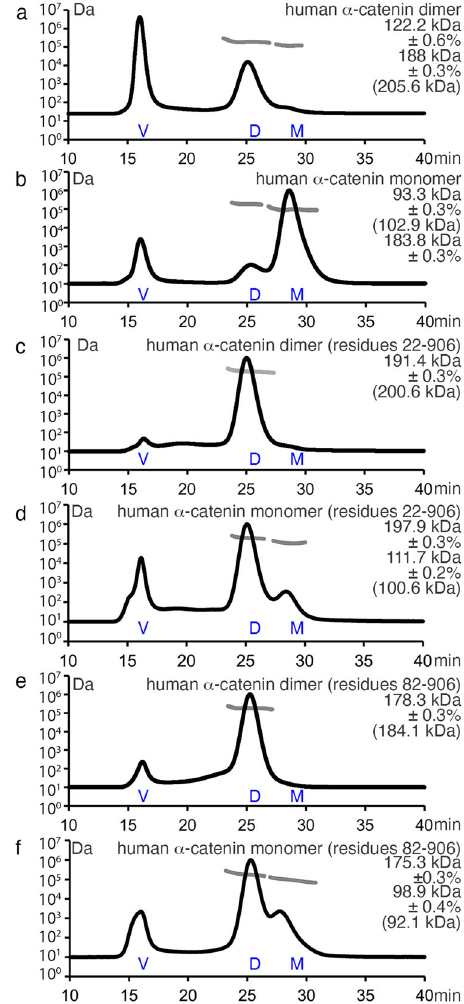
Fig. 2 Determination of absolute masses by size exclusion chromatography and multi-angle light scattering. Full-length human α - catenin forms a dimer and monomer. Separate pooling of monomeric or dimeric peaks from a size exclusion chromatography run was subsequently analyzed by size exclusion chromatography multi-angle light scattering. The ordinate indicates the molar mass (light gray trace) expressed on a logarithmic scale, and the abscissa represents the time in minutes for the light scattering pro fi le (black trace). The ordinate corresponding to the light scattering signal is not shown. The experimental absolute masses are shown. Values in brackets are the molecular weights as calculated from the respective polypeptide chains. a Human dimeric α -catenin, b human monomeric α -catenin, c human dimeric α -catenin Δ 1 – 21, d human monomeric α -catenin Δ 1 – 21, e human dimeric α -catenin Δ 1 – 81, and f human monomeric α -catenin Δ 1 –